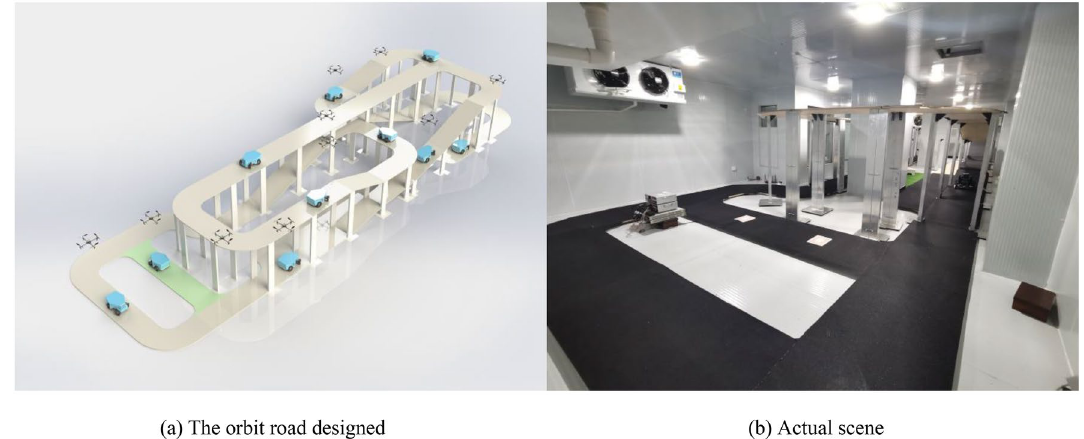
Figure 3 Environmental